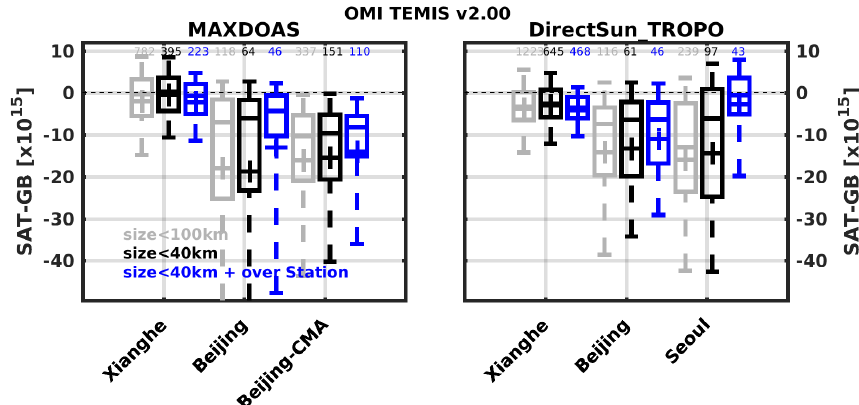
Figure 7. Impact of the OMI pixel size (pixels smaller than 100 and 40km in grey and black respectively) and with filtering on pixels only above the station (blue) on the differences’ deviation between satellite and ground-based data at a few stations: Xianghe, Beijing, Beijing- CMA and Seoul. The number of comparison points is indicated on top with the corresponding colors. The box-and-whisker plots are defined as follows: crosses for the mean values, horizontal lines for the median, boxes for the 25 and 75 percentile and vertical lines for the 9 and 91